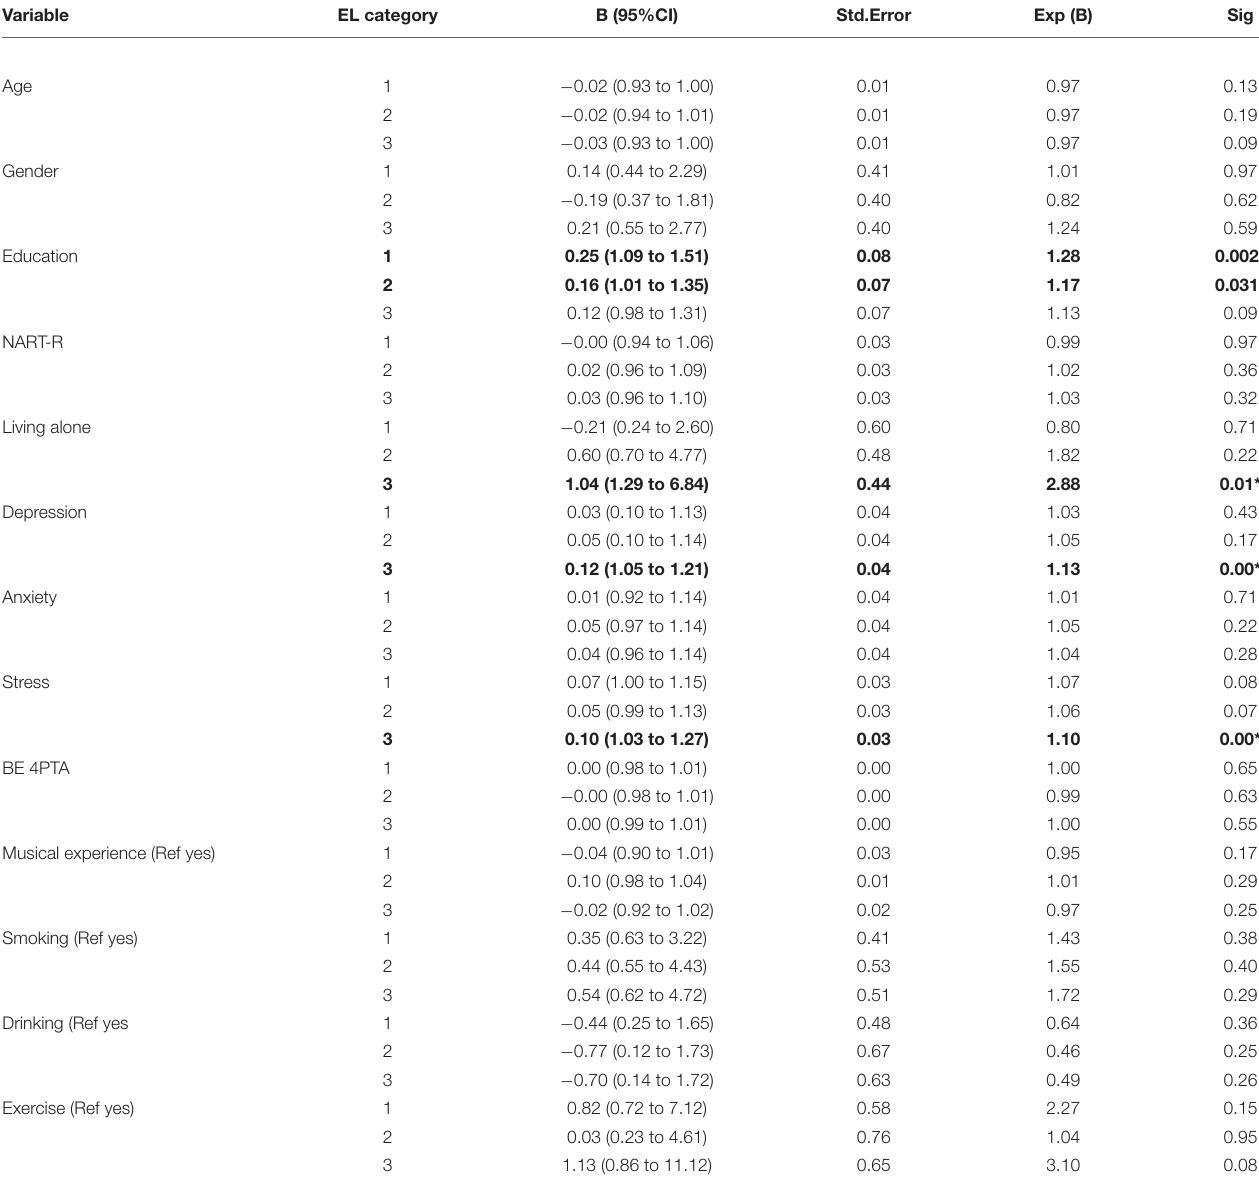
TABLE 7 | Association between living arrangement, depression, and Stress on SL categories.